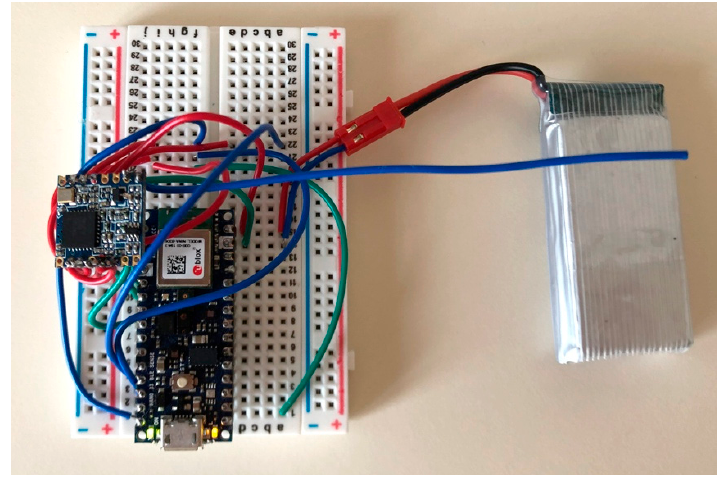
Figure 8. Prototype of the monitoring device.